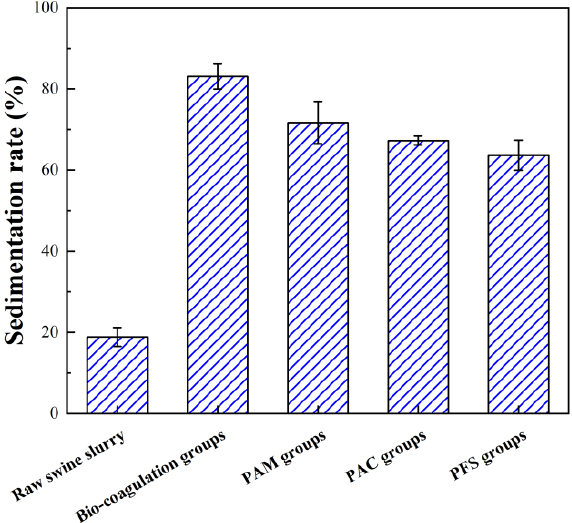
Figure 1. Sedimentation rate of swine wastewater after various coagulation treatments.